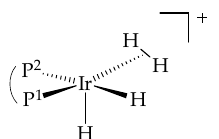
Figure 10. Iridium dihydrogen–dihydride complex, a proposed intermediate in an acetate-free mechanism.